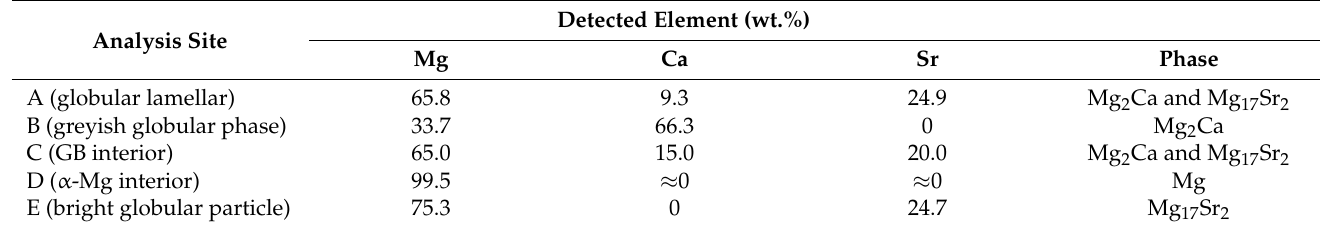
Figure 3. The XRD spectra of as-cast CP Mg and Mg-1.0Ca-0.5Sr alloy.